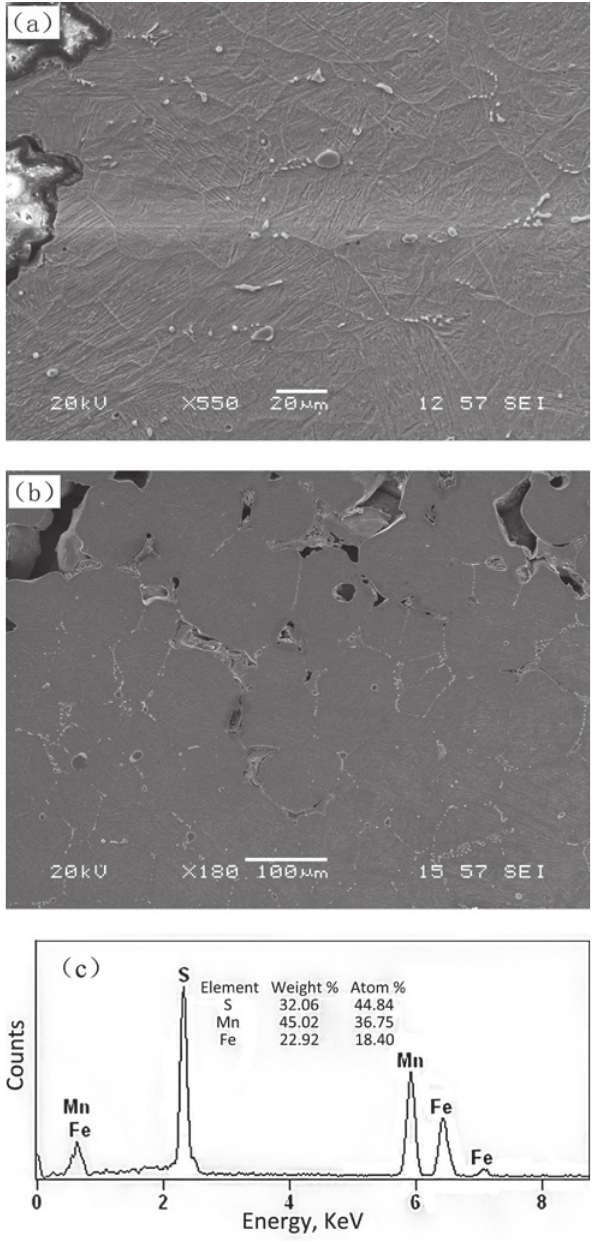
Fig. 8: Typical longitudinal microstructures of quenched fractures for steel 2: (a) microstructure near fracture at 1150 °C; (b) microstructure near fracture at 1100 °C; (c) EDS of sulfide phases